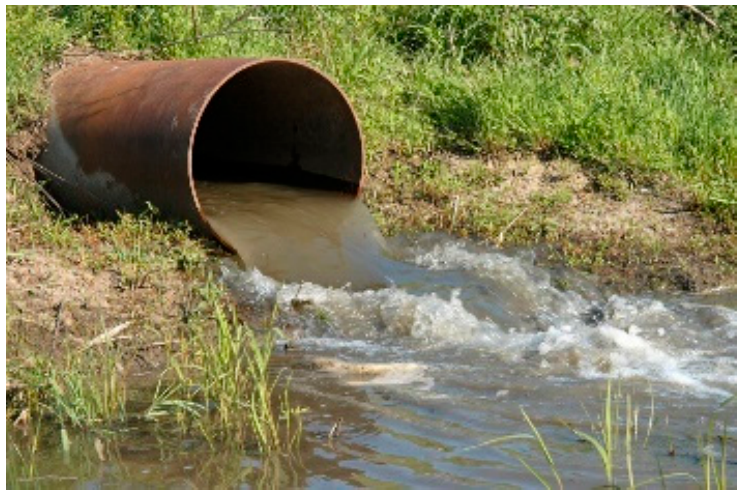
Figure 11. Polluted Water flowing from a drain pipe into a small stream. wikimedia.org/wikipedia/commons (accessed 20 February 2021). Public Domain.